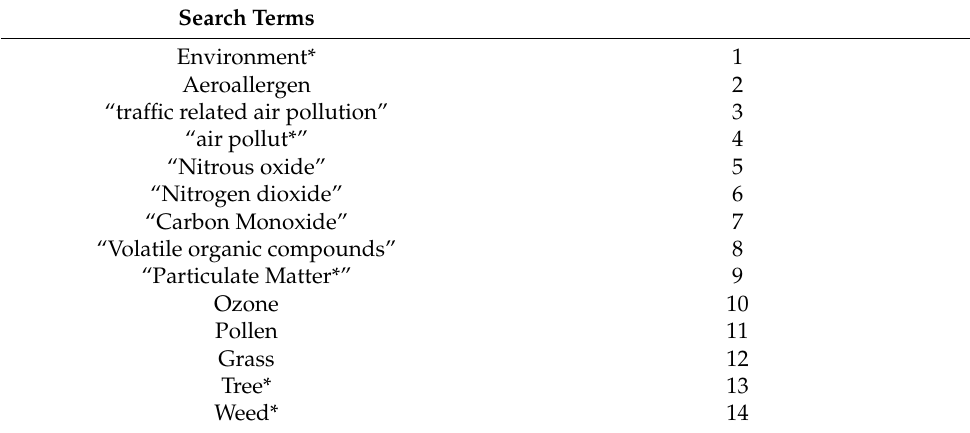
Table 1. Search terms used for the search